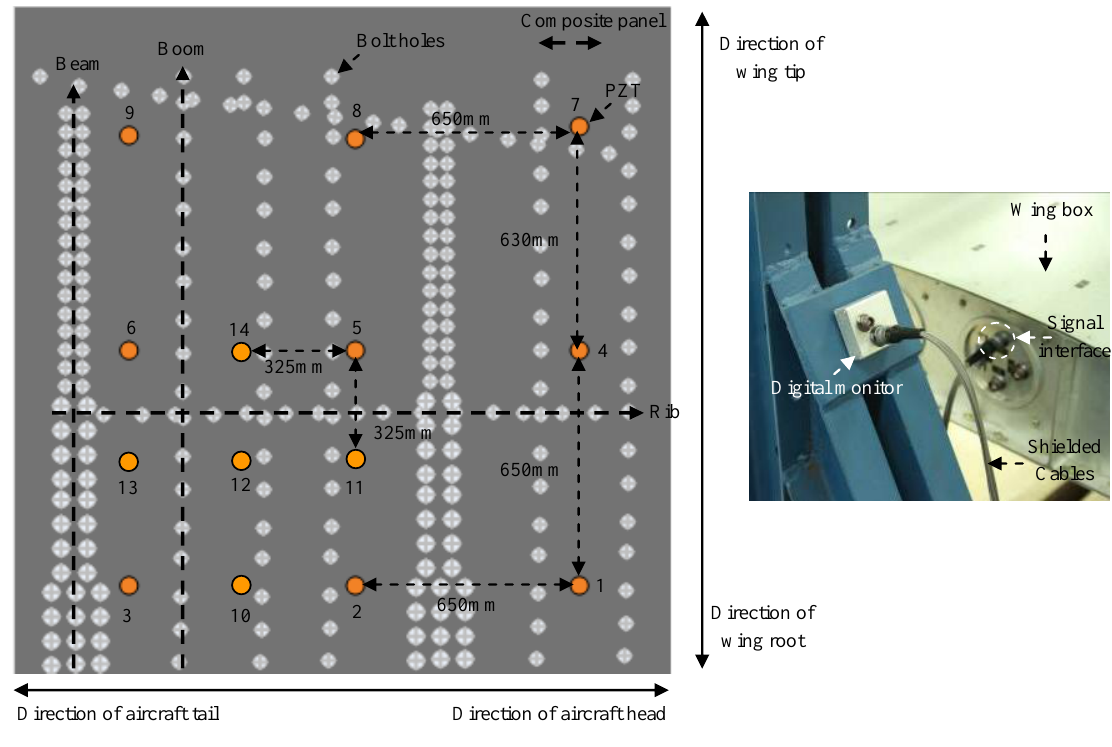
Figure 14. Illustration of the validation experimental system.